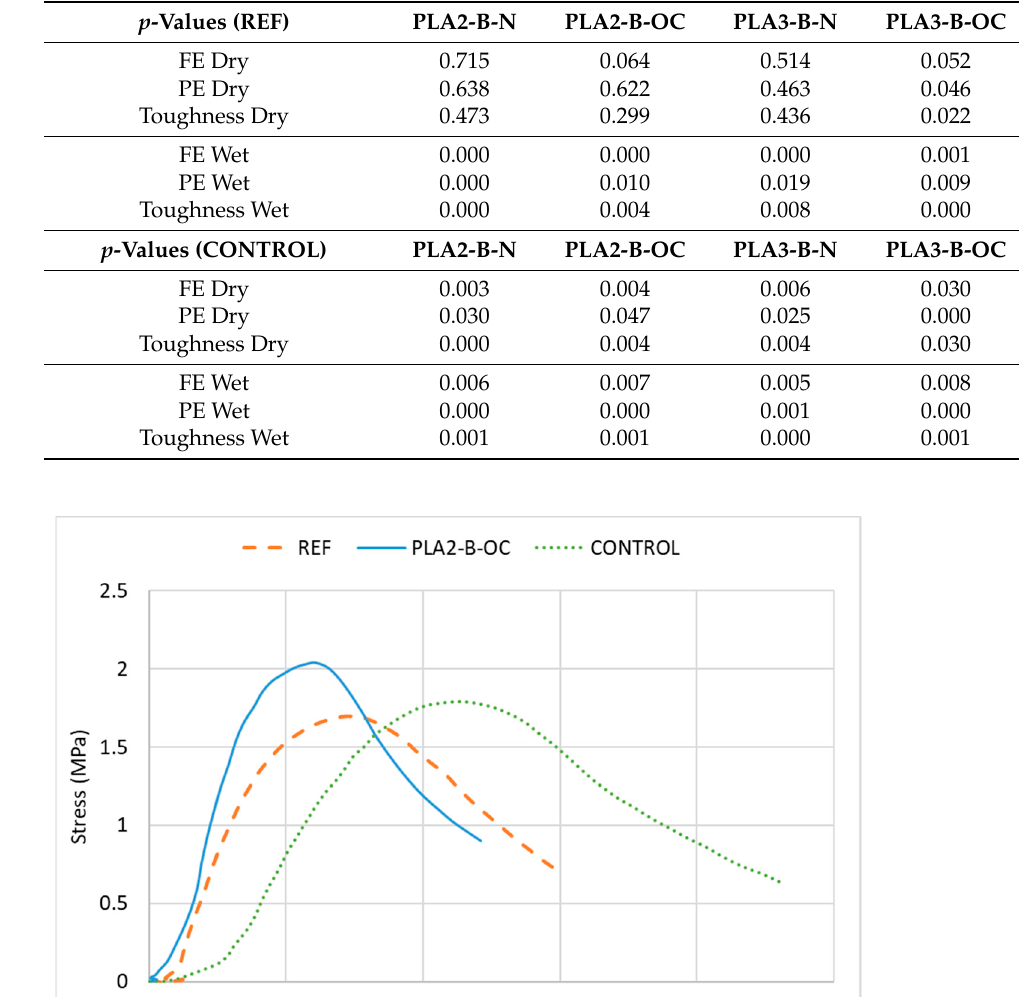
Table 9. p -values for cracking energy results.